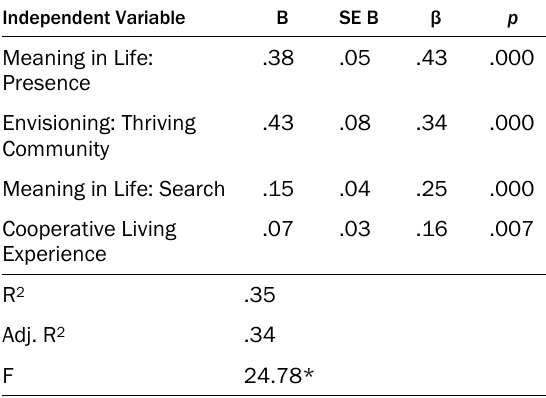
Table 12. Dependent Variable: